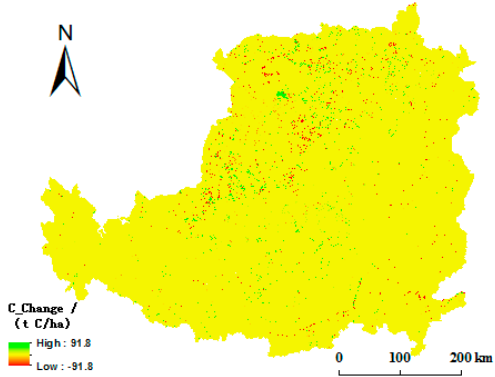
Figure 5. Changes in carbon storage due to LUCC from 2000 to 2010.